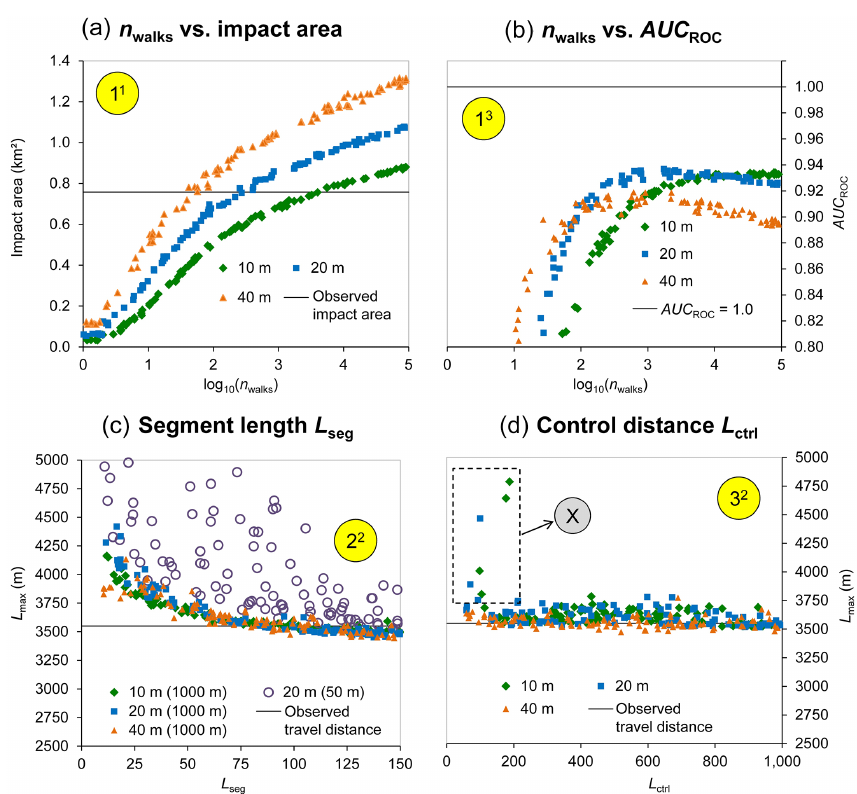
Figure 6. Results of the tests 1–3 (number of test indicated in the yellow circle). Number of random walks plotted against (a) the impact area and (b) the area under the ROC curve. (c) Computed travel distance L max as a function of L seg (in the legend, the corresponding value of L ctrl is given in parentheses). (d) Computed L max as a function of L ctrl